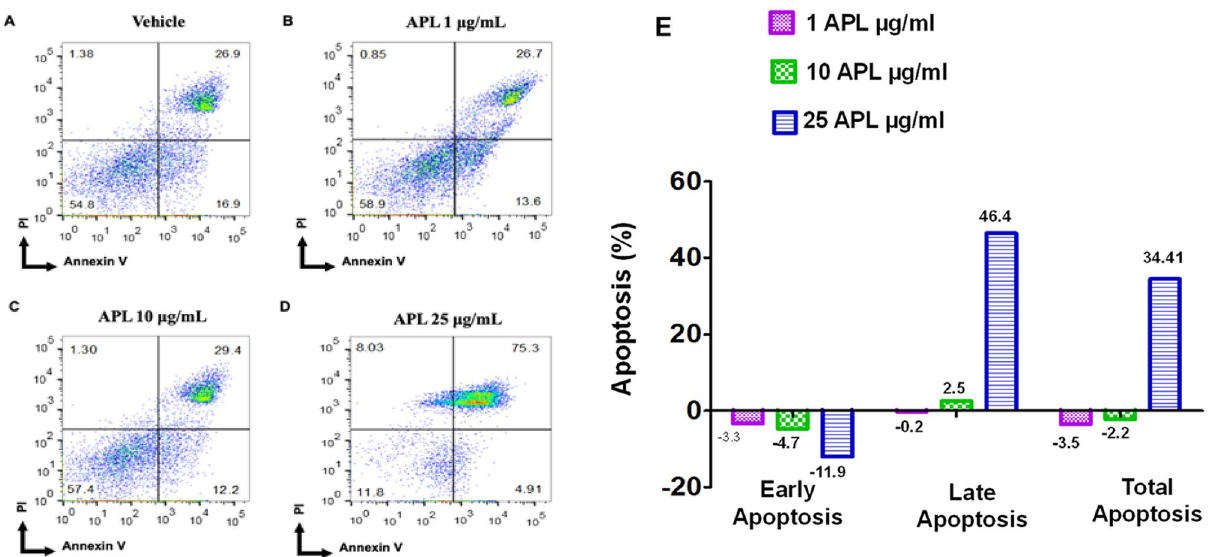
Figure 5. Apoptosis in B16 melanoma cells by APL: This was determined by Annexin V-PI staining after 24 h treatment with vehicle ( A ) or APL ( Psiadia lithospermifolia ) at different concentrations such as 1 µg/ml ( B ), 10 µg/ml ( C ), 25 µg/ml ( D ). The data presented are representative of three independent experiments. Bar chart ( E ) shows quantitative data of average of three independent flow cytometry experiments with apoptosis in APL groups relative to vehicle